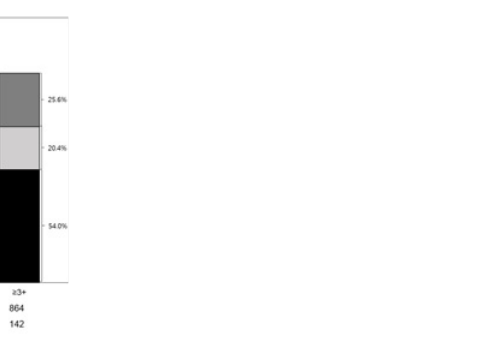
Table 2. Hazard ratios (95%CI) for cause-specific mortality by eGFR in Korean Heart Study.